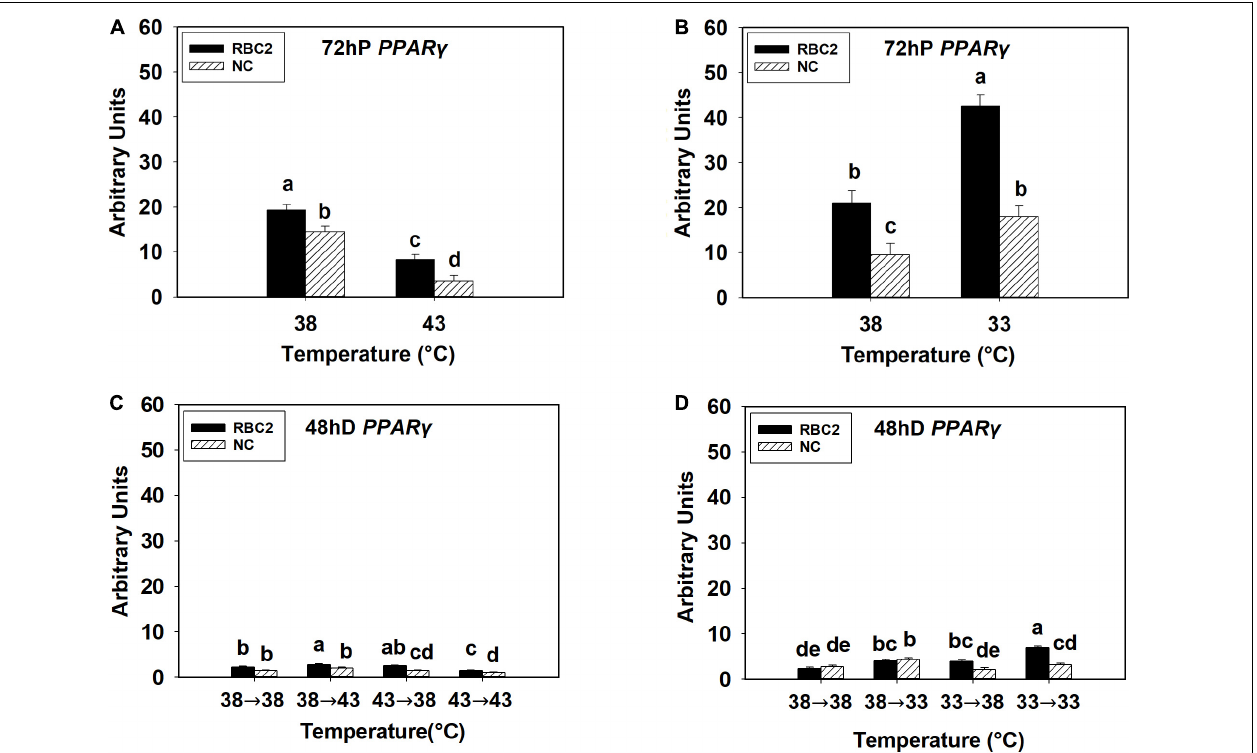
FIGURE 1 | Expression of peroxisome proliferator-activated receptor gamma ( PPAR γ ) at 72 h of proliferation (72 hP) and 48 h of differentiation (48 hD) in satellite cells isolated from the pectoralis major (p. major) muscle of 7-day-old Randombred Control Line 2 (RBC2) and 7-day-old Nicholas Commercial (NC) turkeys. (A) Satellite cell proliferation at 38 ◦ or 43 ◦ C for 72 h. (B) Satellite cell proliferation at 38 ◦ or 33 ◦ C for 72 h. (C) Satellite cell proliferation for 72 h and differentiation for 48 h, both at 38 ◦ C (38 ◦ → 38 ◦ C); proliferation at 38 ◦ C for 72 h and differentiation at 43 ◦ C for 48 h (38 ◦ → 43 ◦ C); proliferation at 43 ◦ C for 72 h and differentiation at 38 ◦ C for 48 h (43 ◦ → 38 ◦ C); or proliferation for 72 h and differentiation for 48 h, both at 43 ◦ C (43 ◦ → 43 ◦ C). (D) Satellite cell proliferation for 72 h and differentiation for 48 h, both at 38 ◦ C (38 ◦ → 38 ◦ C); proliferation at 38 ◦ C for 72 h and differentiation at 33 ◦ C for 48 h (38 ◦ → 33 ◦ C); proliferation at 33 ◦ C for 72 h and differentiation at 38 ◦ C for 48 h (33 ◦ → 38 ◦ C); or proliferation for 72 h and differentiation for 48 h, both at 33 ◦ C (33 ◦ → 33 ◦ C). Each graph bar represents a mean arbitrary unit, and each error bar represents a standard error of the mean. Mean values without a same letter were significantly different ( P ≤